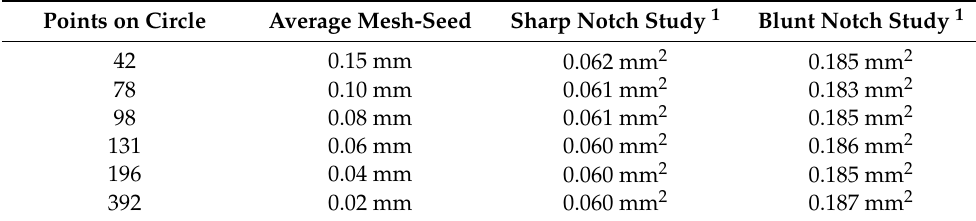
Table 4. Effect of mesh-seed on evaluated control volume for sharp and blunt notch assessment of circular hole-in-plate geometry. Points on Circle Average Mesh-Seed Sharp Notch Study 1 Blunt Notch Study